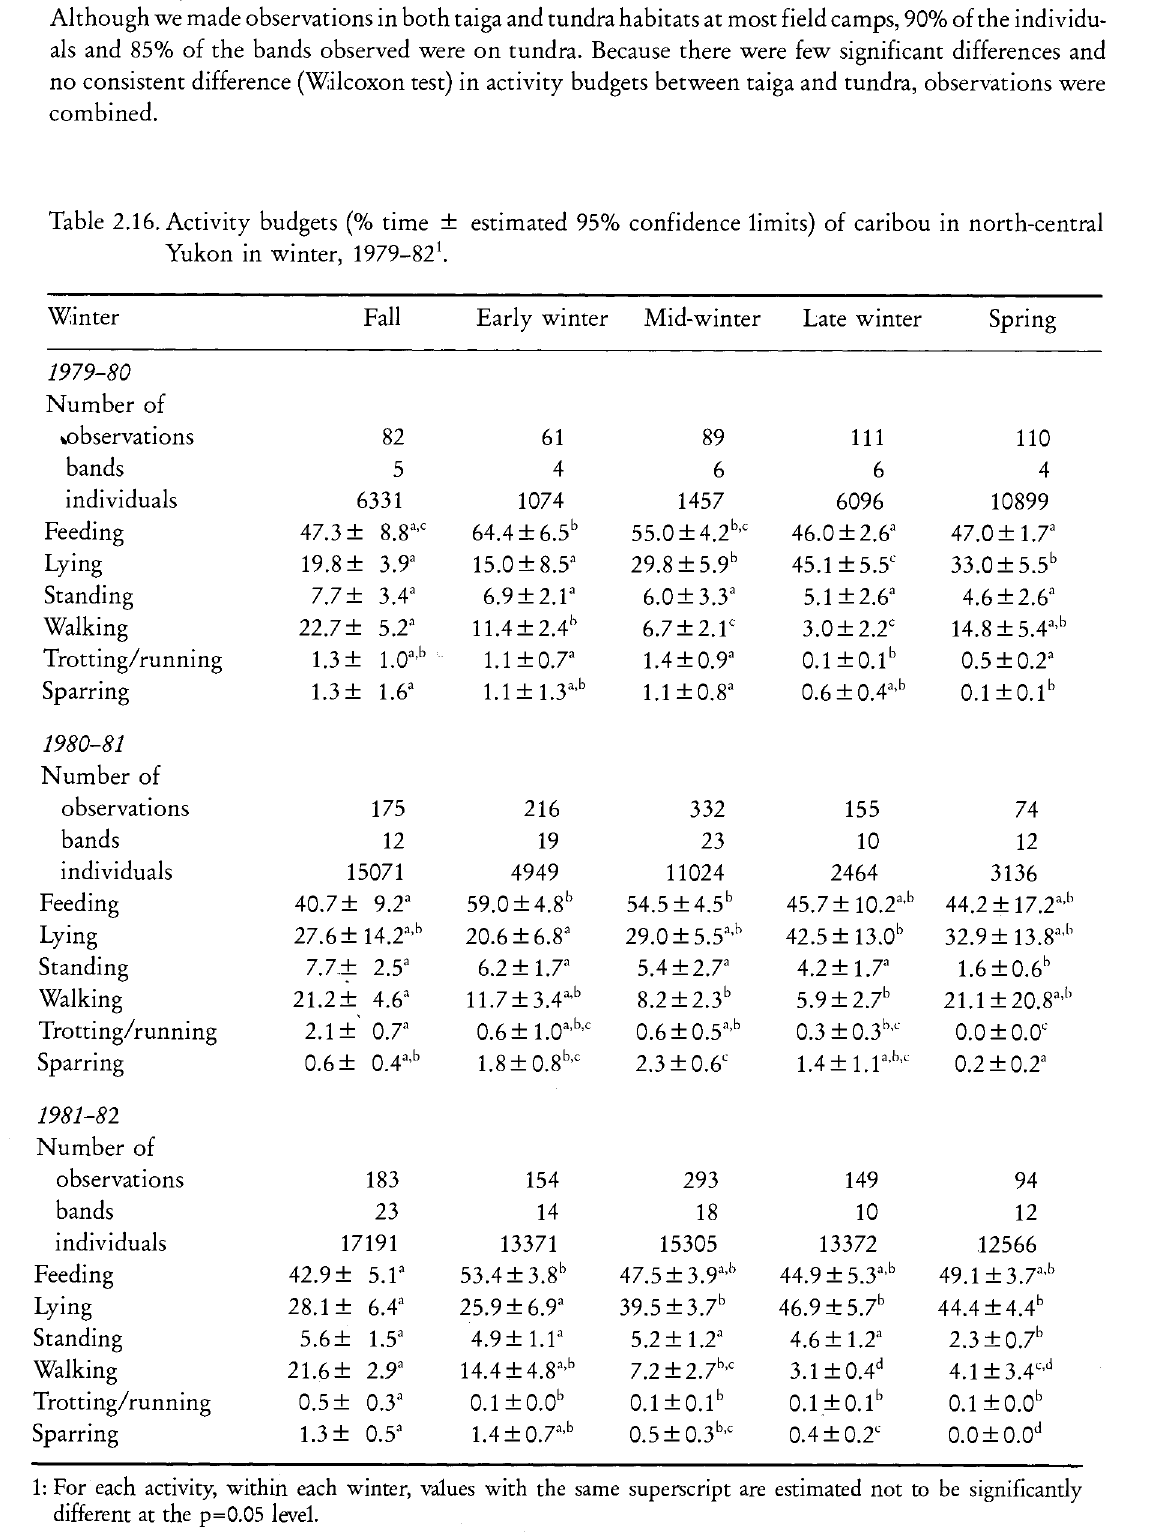
Table 2.16. Activity budgets (% time ± estimated 95% confidence limits) of caribou in north-central Yukon in winter, 1979-82 1